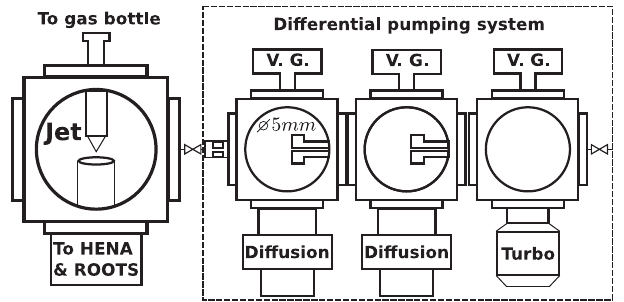
FIG. 2. 2D Schematic view of SUGAR where the three 5 mm diameter apertures can be seen: two of them inside of each of the two middle chambers [each of these have also a vacuum gauge (V.G.)], whereas the third one connects the differential pumping system to the scattering chamber. The V.G. ’ s are employed to limit the gas throughput and still allow the beam to reach the